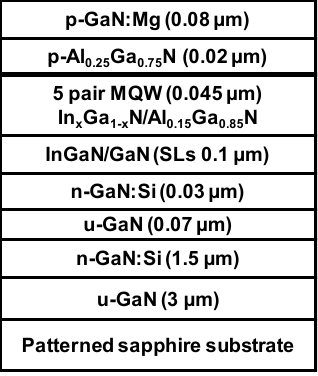
Figure 1. Schematic structure of the light-emitting diode (LED) samples under study. Table 1. Device characteristics of the near-ultraviolet (NUV) LED samples under study. V F : Forward-